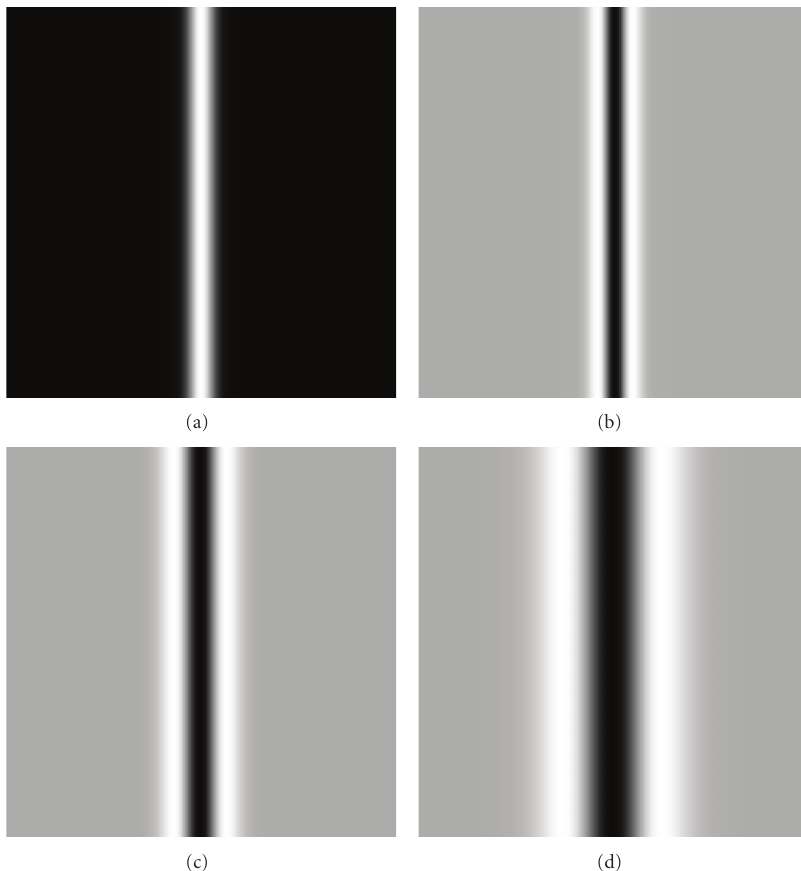
Figure 3: Original image convolved with second-order Gaussian derivatives. (a) Original image has an object with Gaussian intensity profile of kernel size σ = 5. (b) Original image convolved with second-order Gaussian derivative of kernel size σ = 1. (c) Original image convolved with second-order Gaussian derivative of kernel size σ = 5. (d) Original image convolved with second-order Gaussian derivative of kernel size σ =